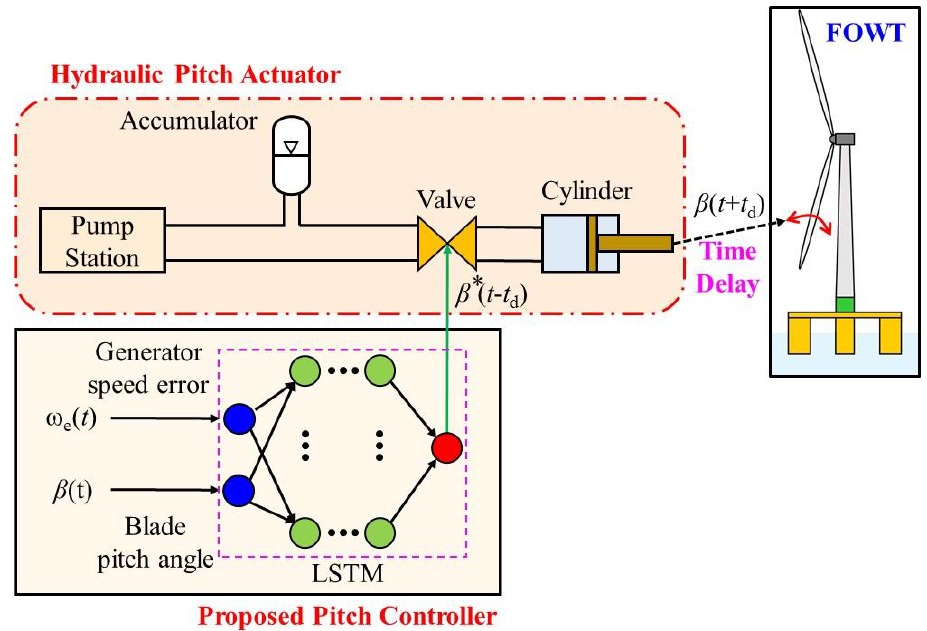
Figure 7. Configuration of the proposed pitch controller with deep learning algorithm. (LSTM, long short-term memory).